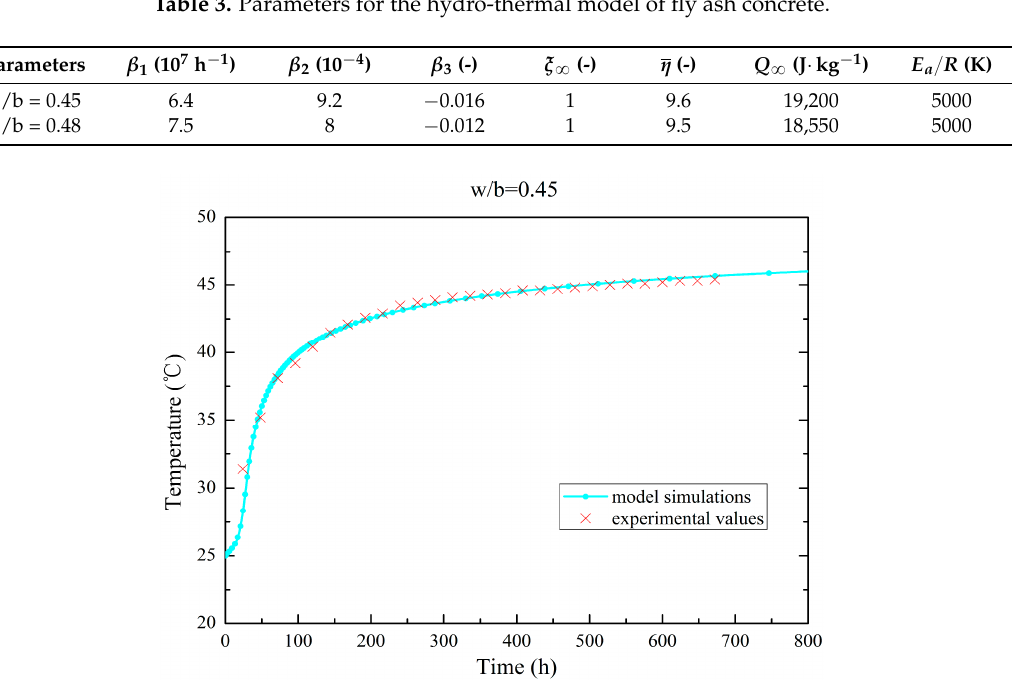
Table 3. Parameters for the hydro-thermal model of fly ash concrete.